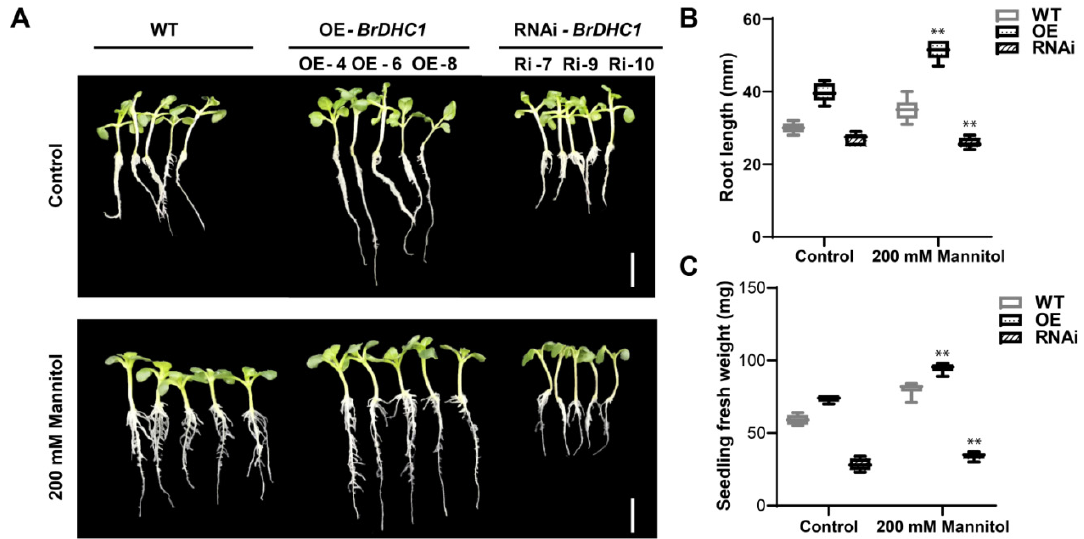
Figure 3. Root growth analysis of the wild-type and the transgenic Brassica rapa plants. ( A ) Root morphology of WT, OE- BrDHC1 , and RNAi- BrDHC1 plants under normal and 200 mM mannitol treatment ( n = 10). ( B ) Main root length statistics of WT, OE- BrDHC1 , and RNAi- BrDHC1 plants under normal and 200 mM mannitol treatment (data represent the means ± SD of 5 replicates; Student’s t test was performed to compare differences between the wild-type and the transgenic plants under 200 mM mannitol treatment, along with one-way analysis of variance (ANOVA), ** p value < 0.01). ( C ) Fresh weight statistics of the seedlings of WT, overexpressing BrDHC1 , and RNAi- BrDHC1 plants under normal and 200 mM mannitol treatment (data represent the means ± SD of 5 replicates; Student’s t test was performed to compare differences between the wild-type and the transgenic plants under 200 mM mannitol treatment, along with one-way analysis of variance (ANOVA), ** p value < 0.01).